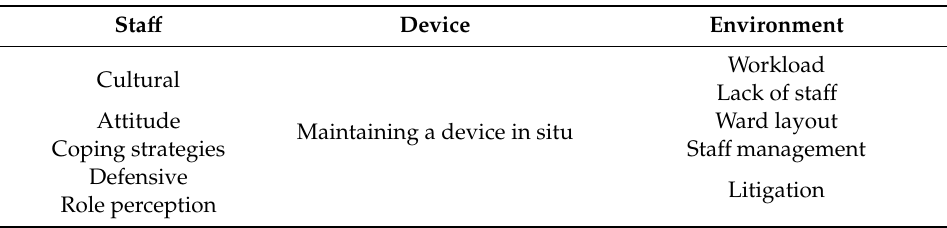
Table 3. Example reasons for the use of